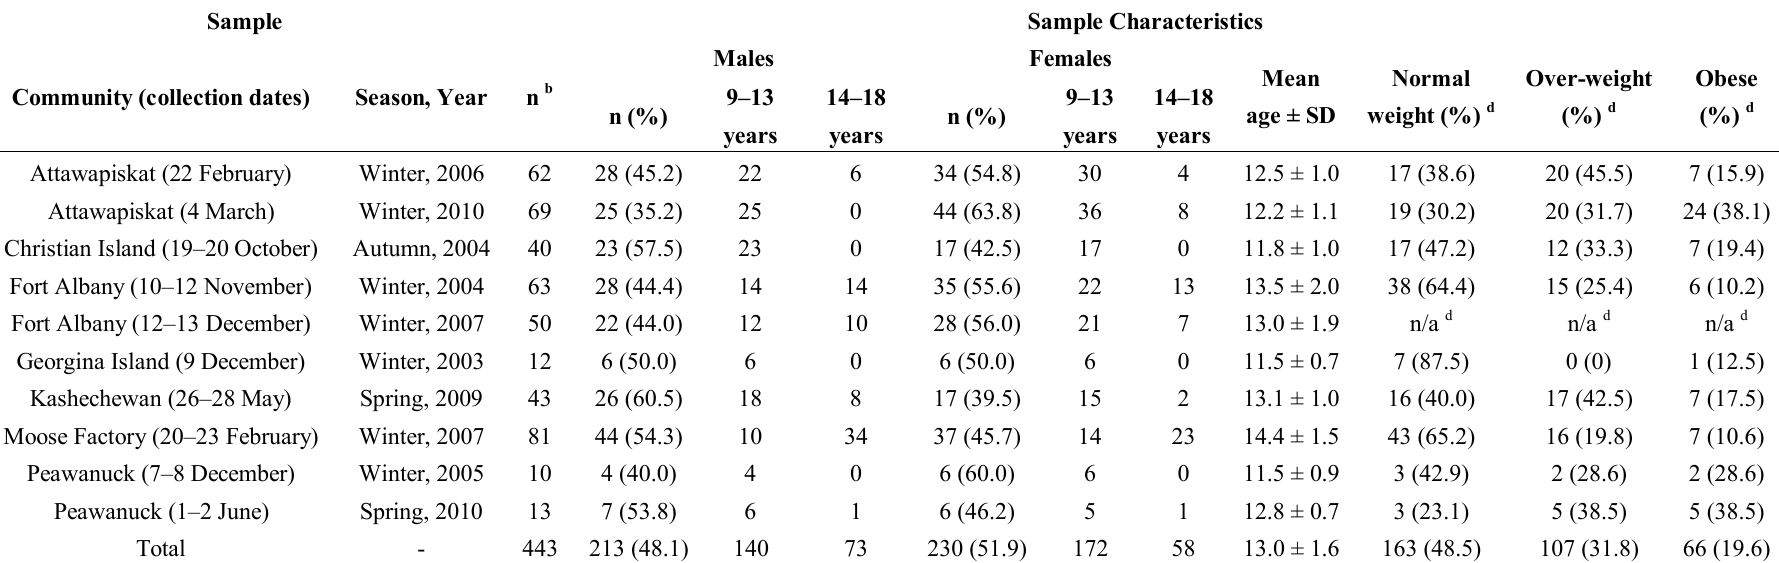
Table 2. Characteristics of the participants in the descriptive comparison of dietary intakes a